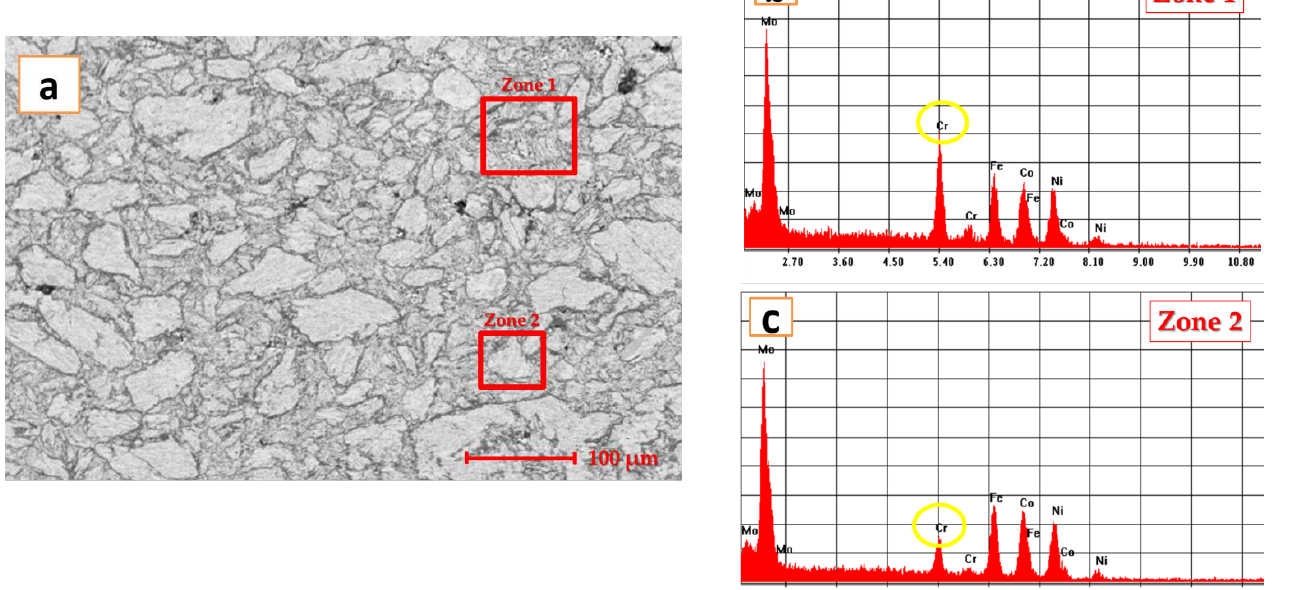
Figure 3. Analyses results of CoCrFeNiMo 0.85 HEA pressed and sintered ( a ) SEM image of the sintered sample, ( b ) EDS analyses for zone 1 and ( c ) EDS analyses for zone 2. The coating obtained with the processed electrodes is presented in Figure 4.